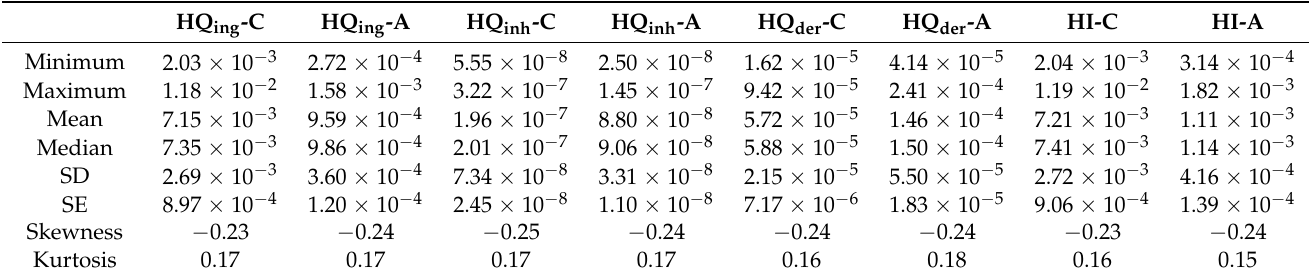
Table 7. Overall values of hazard quotient (HQ), and hazard index (HI), in the three exposure routes of Zn for children (C) and adults (A) in Klang River estuary and a site in Juru estuary. N = 9. HQ ing -C HQ ing -A HQ inh -C HQ inh -A